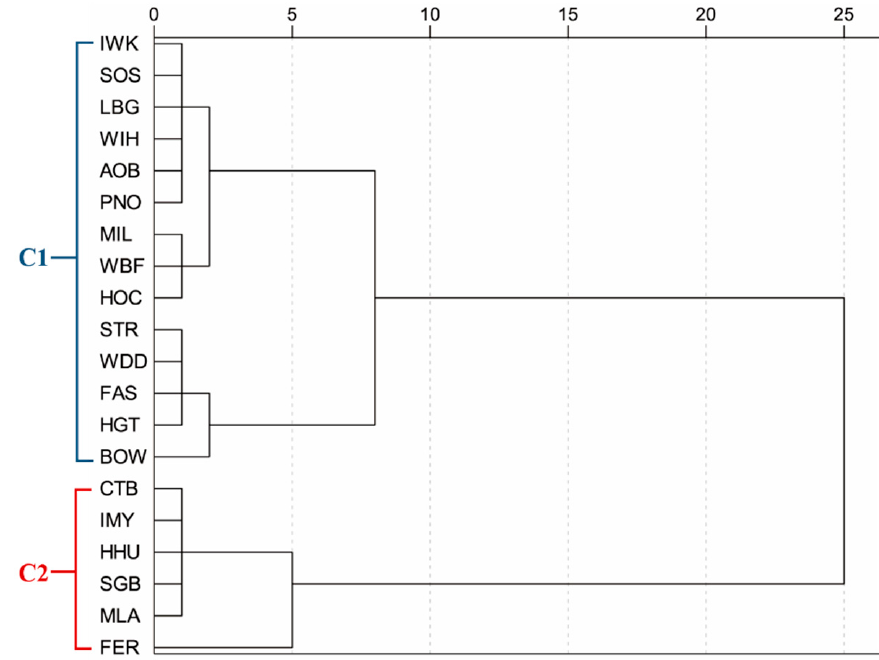
Figure 4. Dendrogram of the agglomerative hierarchical clustering (AHC) analysis of programs. C1 and C2 represent the two clusters.